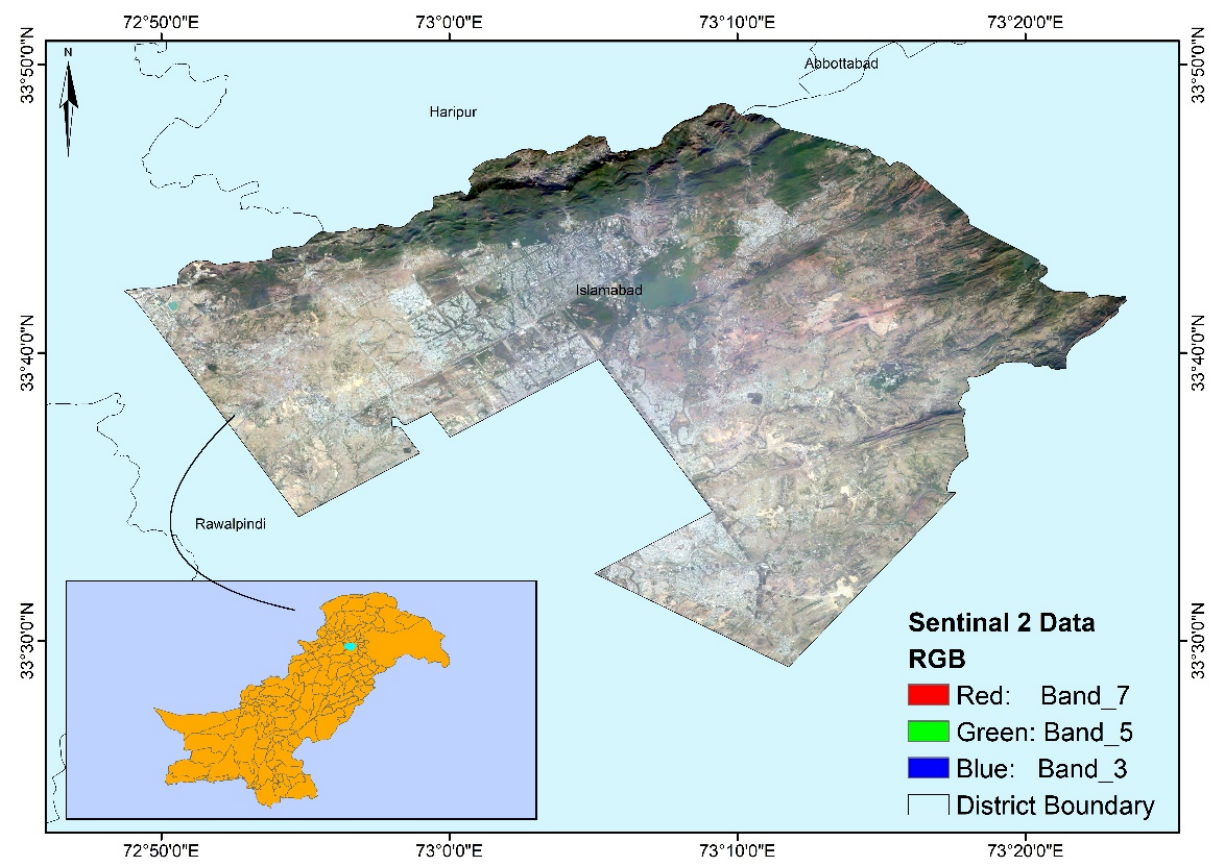
Figure 1. The study area (Islamabad) and its zones.